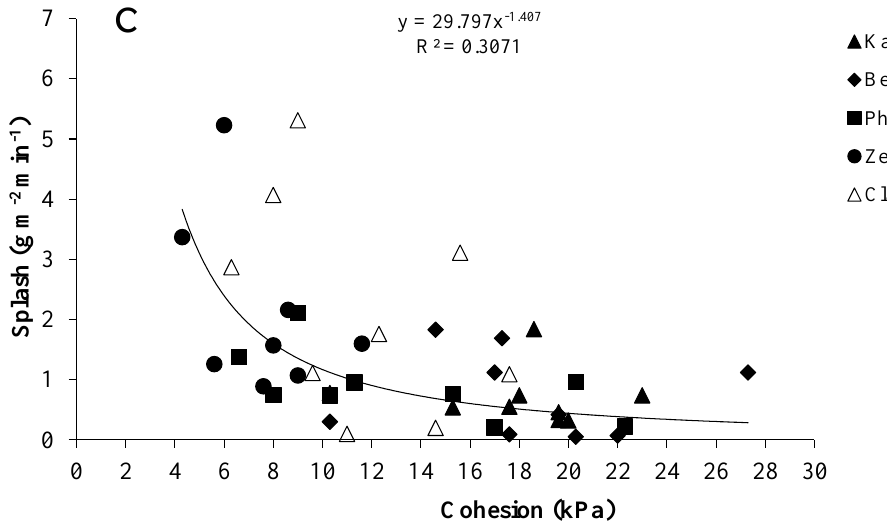
Figure 5. Relationships between splash erosion and cohesion in clay–sand mixtures and clay soil following various wetting and drying cycles: ( a ) without wetting and drying (W&D) cycles, ( b ) after one cycle of W&D ( c ), and after two cycles of W&D.